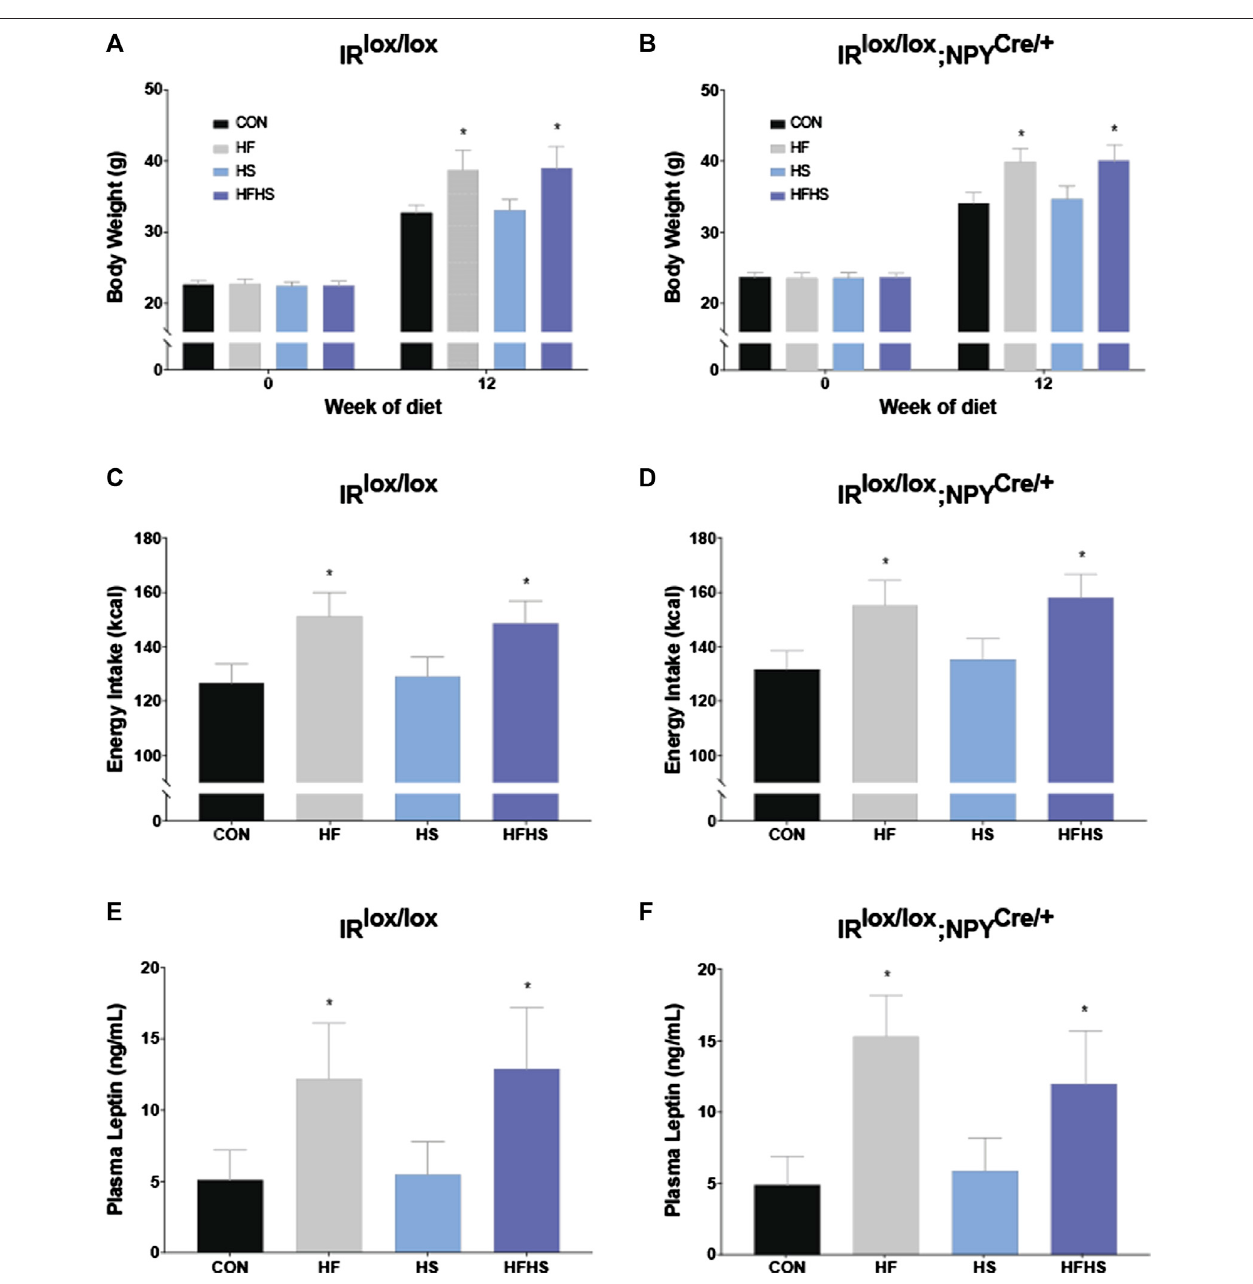
FIGURE 1 | Body weight, energy intake and plasma leptin. Body weights of IR lox/lox and IR lox/lox ;NPY Cre/+ mice increased after 12 weeks of diet intervention in all treatment groups. Body weight was further upregulated after 12 weeks of diet in HF and HFHS groups compared to CON and HS diet group (A, B) . Energy intake of IR lox/lox and IR lox/lox ;NPY Cre/+ mice was higher in HF and HFHS treatment groups compared to CON and HS diet group (C, D) . Plasma leptin recordings of IR lox/lox and IR lox/lox ;NPY Cre/+ micewerehigherinHFandHFHStreatmentgroupscomparedtoCONandHSgroup. (E,F) .CON=chowdiet,HF=highfatdiet,HS=highsugar diet, HFHS = high fat and high sugar diet. Values are expressed as mean ± SEM. * = p < 0.05. Analysed by a mixed ANOVA for body weight and a factorial ANOVA for energy intake and plasma leptin. IR lox/lox ; n = 48 (12/diet group). IR lox/lox ;NPY Cre/+ ; n = 48 (12/diet group).